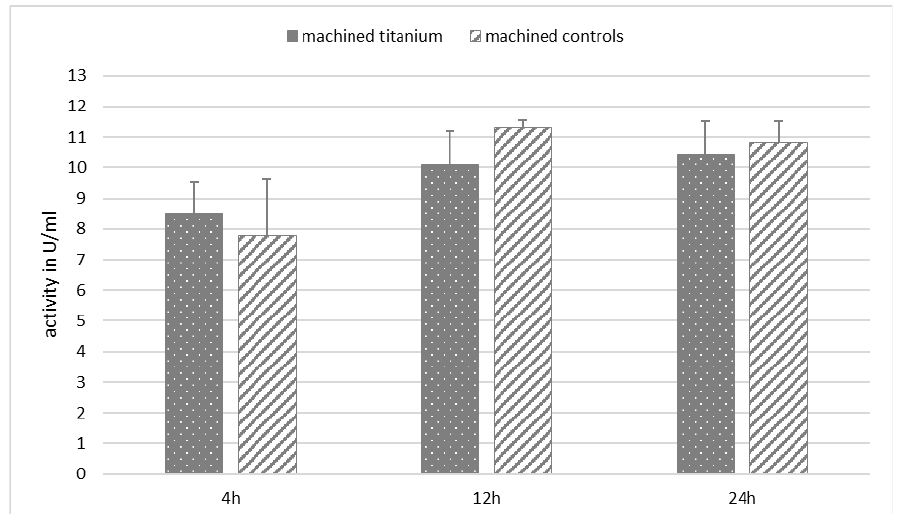
Figure A1. Comparison of alkaline phosphatase activity after 4, 12, 24 h between machined titanium samples and controls. The bars correspond to the mean value, the line on top to the ± standard deviation.